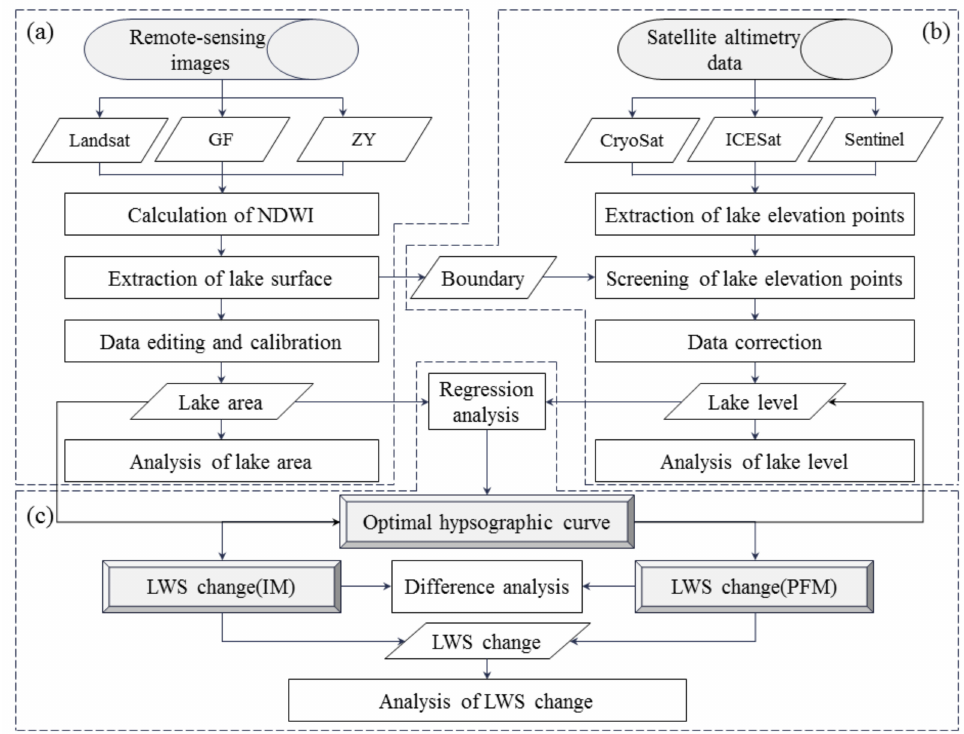
Figure 2. Content and method on ( a ) extraction of the lake area, ( b ) extraction of the lake water level, and ( c ) estimation of the lake water storage (LWS)